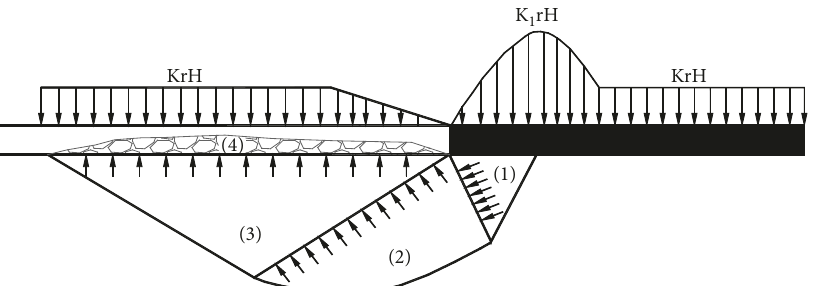
Figure 9: Illustration of different force structures in the mining floor. (1) Subjective pressure zone. (2) Transition zone. (3) Passive pressure zone. (4) Floor heaving